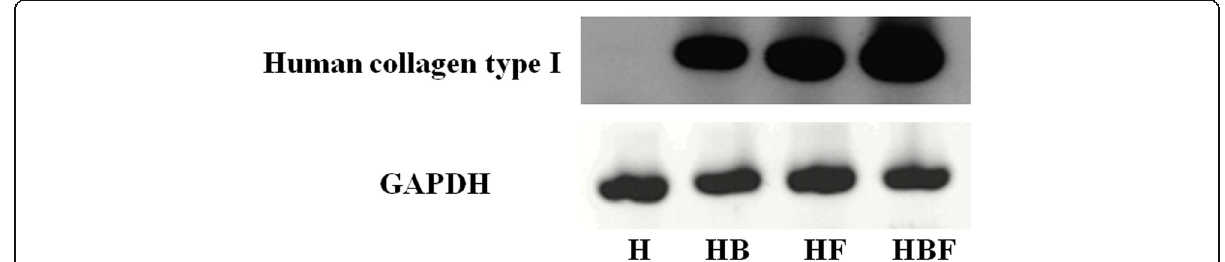
Fig. 7 RT-PCR of human collagen type I. Human type I collagen was detected in hydrogel combined with bFGF (HB), hydrogel combined with fibroblasts (HF), and hydrogel mixed with bFGF and fibroblasts (HBF). GAPDH was used as an internal control. H: hydrogel